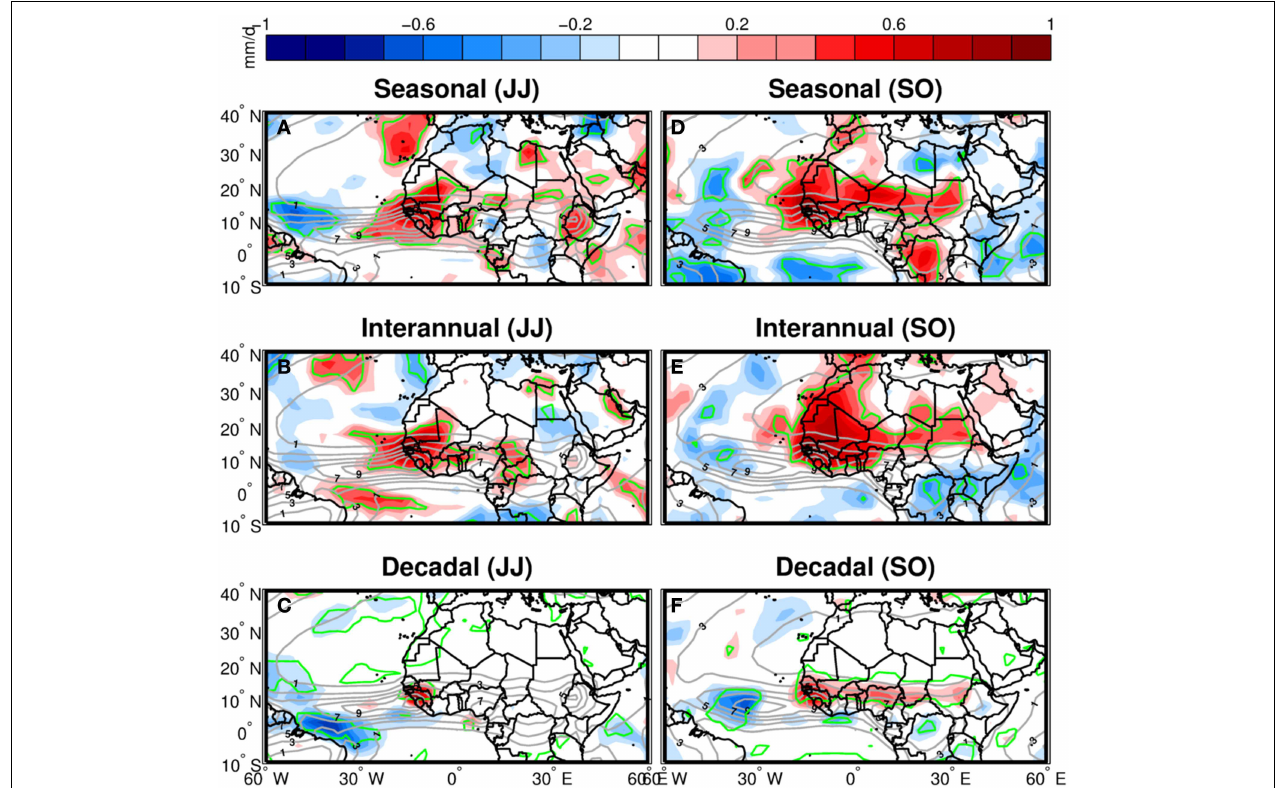
FIGURE 7 | As for Figure 5 but for June–July (JJ, A–C) and September–October (SO, D–F).